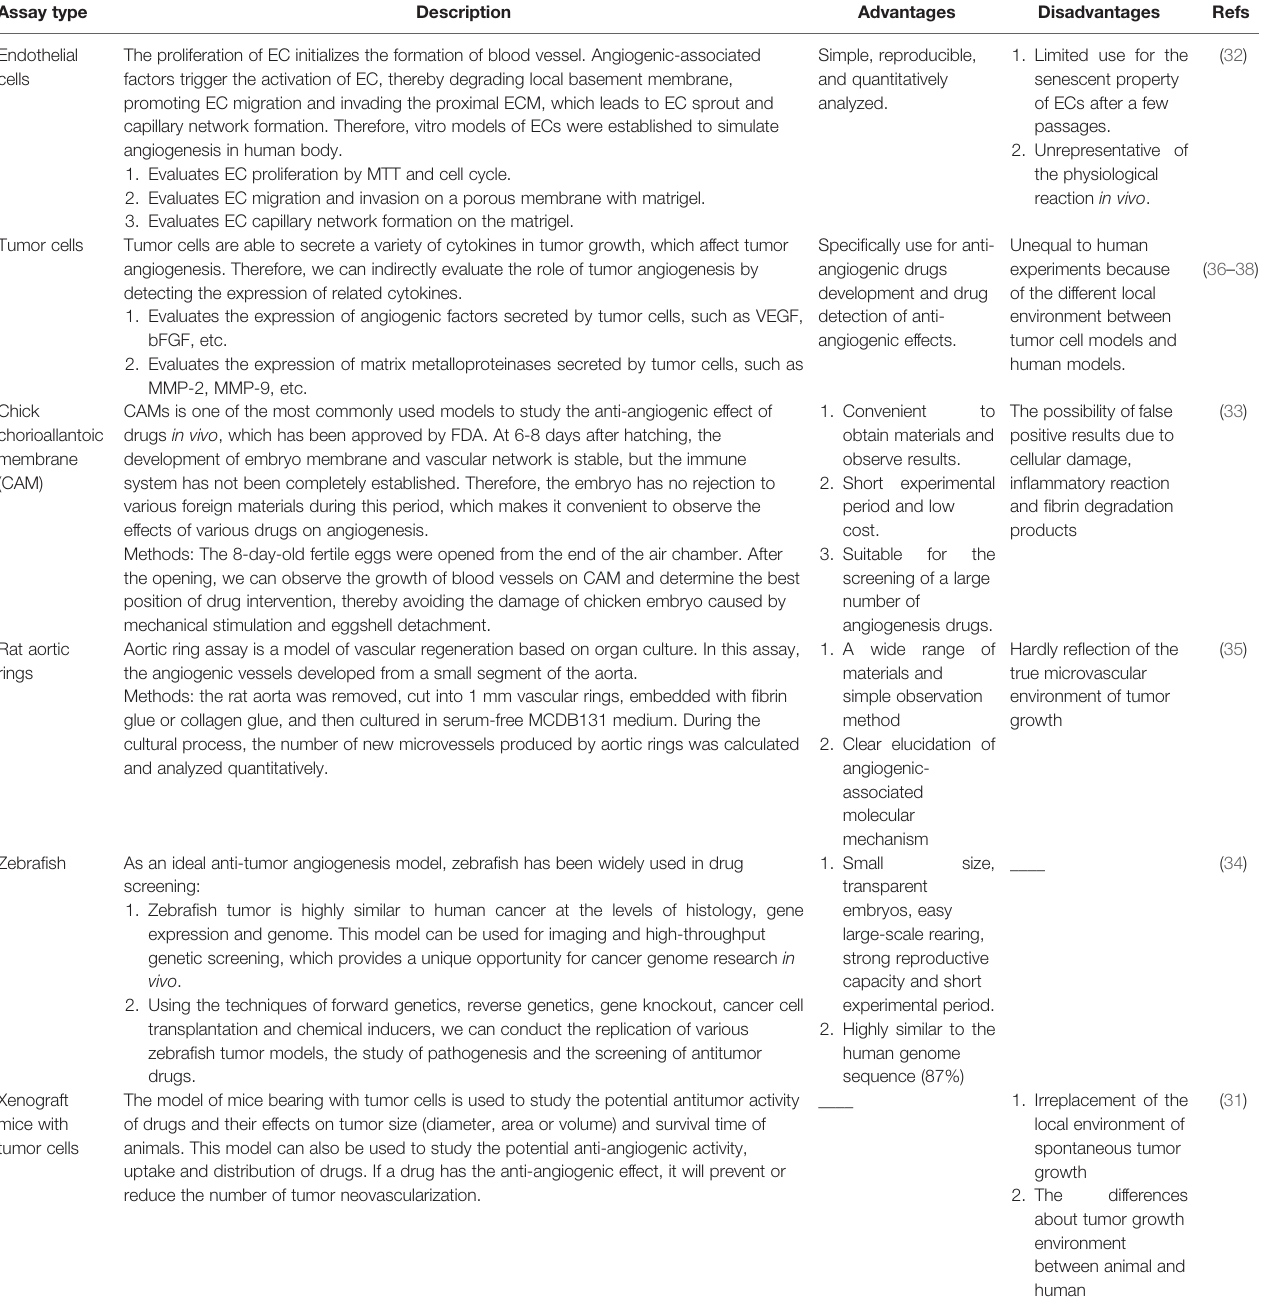
TABLE 1 | Properties of common experimental models of angiogenesis in vivo and in vitro